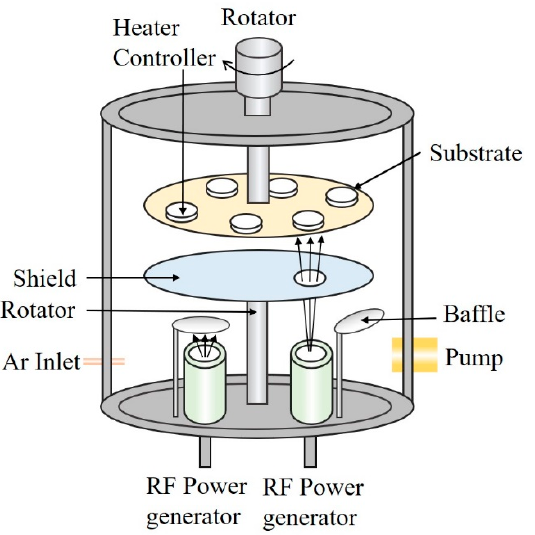
Figure 1. Schematic diagram of the FJL560CI2 magnetron sputtering system. RF: radio-frequency.